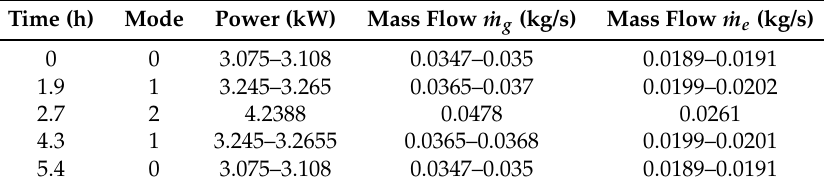
Table 7. Behavior of the variable mode for a radiation of 500 kW/m 2